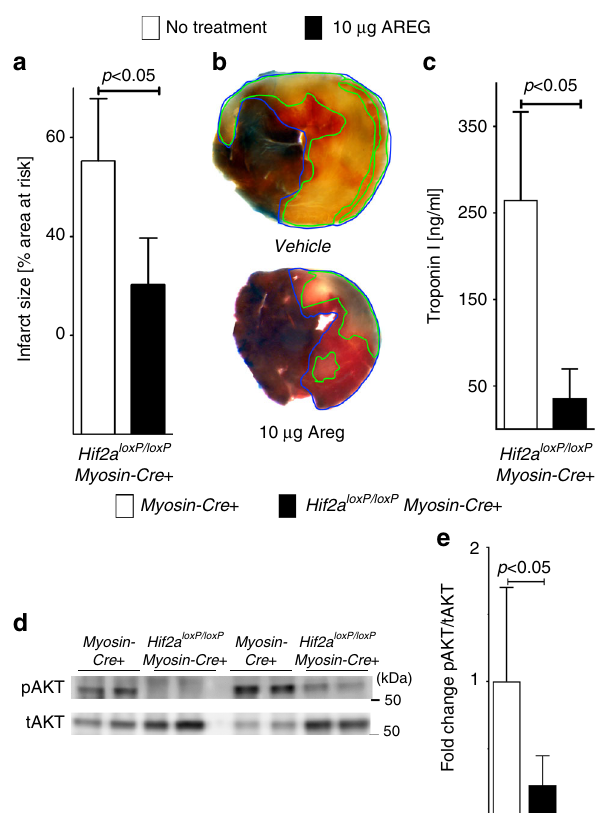
Fig. 8 Reconstitution of cardiomyocyte-speci fi c Hif2a-de fi cient mice with recombinant amphiregulin. a – c Hif2a loxP/loxP Myosin-Cre + of similar